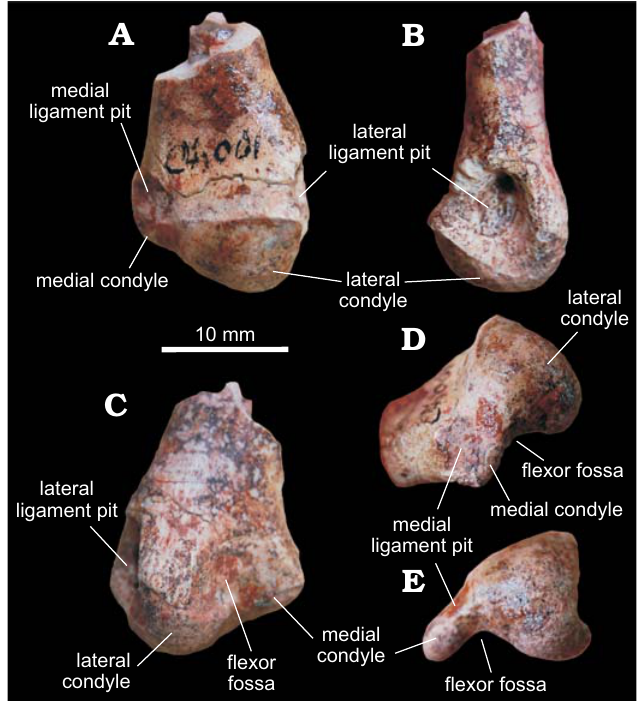
Fig. 7. Distal end of metatarsal I of a sauropodomorph from Sacisaurus site, Late Triassic Caturrita Formation, Agudo, Rio Grande do Sul, Brazil; MCN PV 10049 in cranial ( A ), lateral ( B ), caudal ( C ), mediodistal ( D ), and distal ( E )